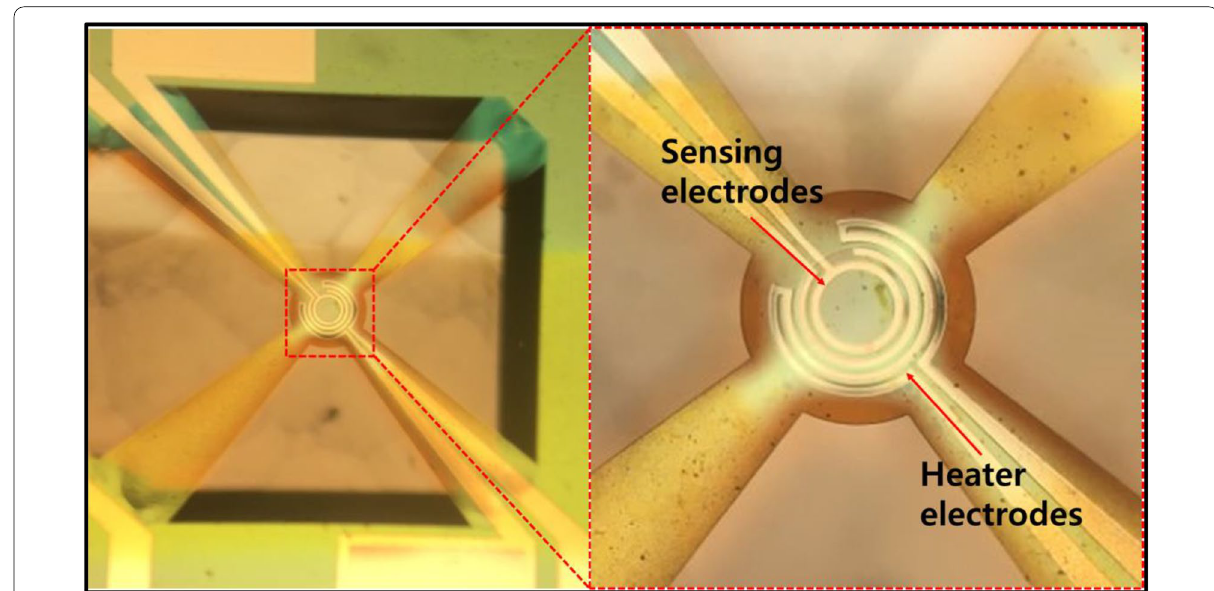
Fig. 1 An optical image of the sensor platform. Ti/Pt electrodes (sensing and heater electrodes) are formed on the suspended SiO 2 /Si 3 N 4 /SiO 2 membrane